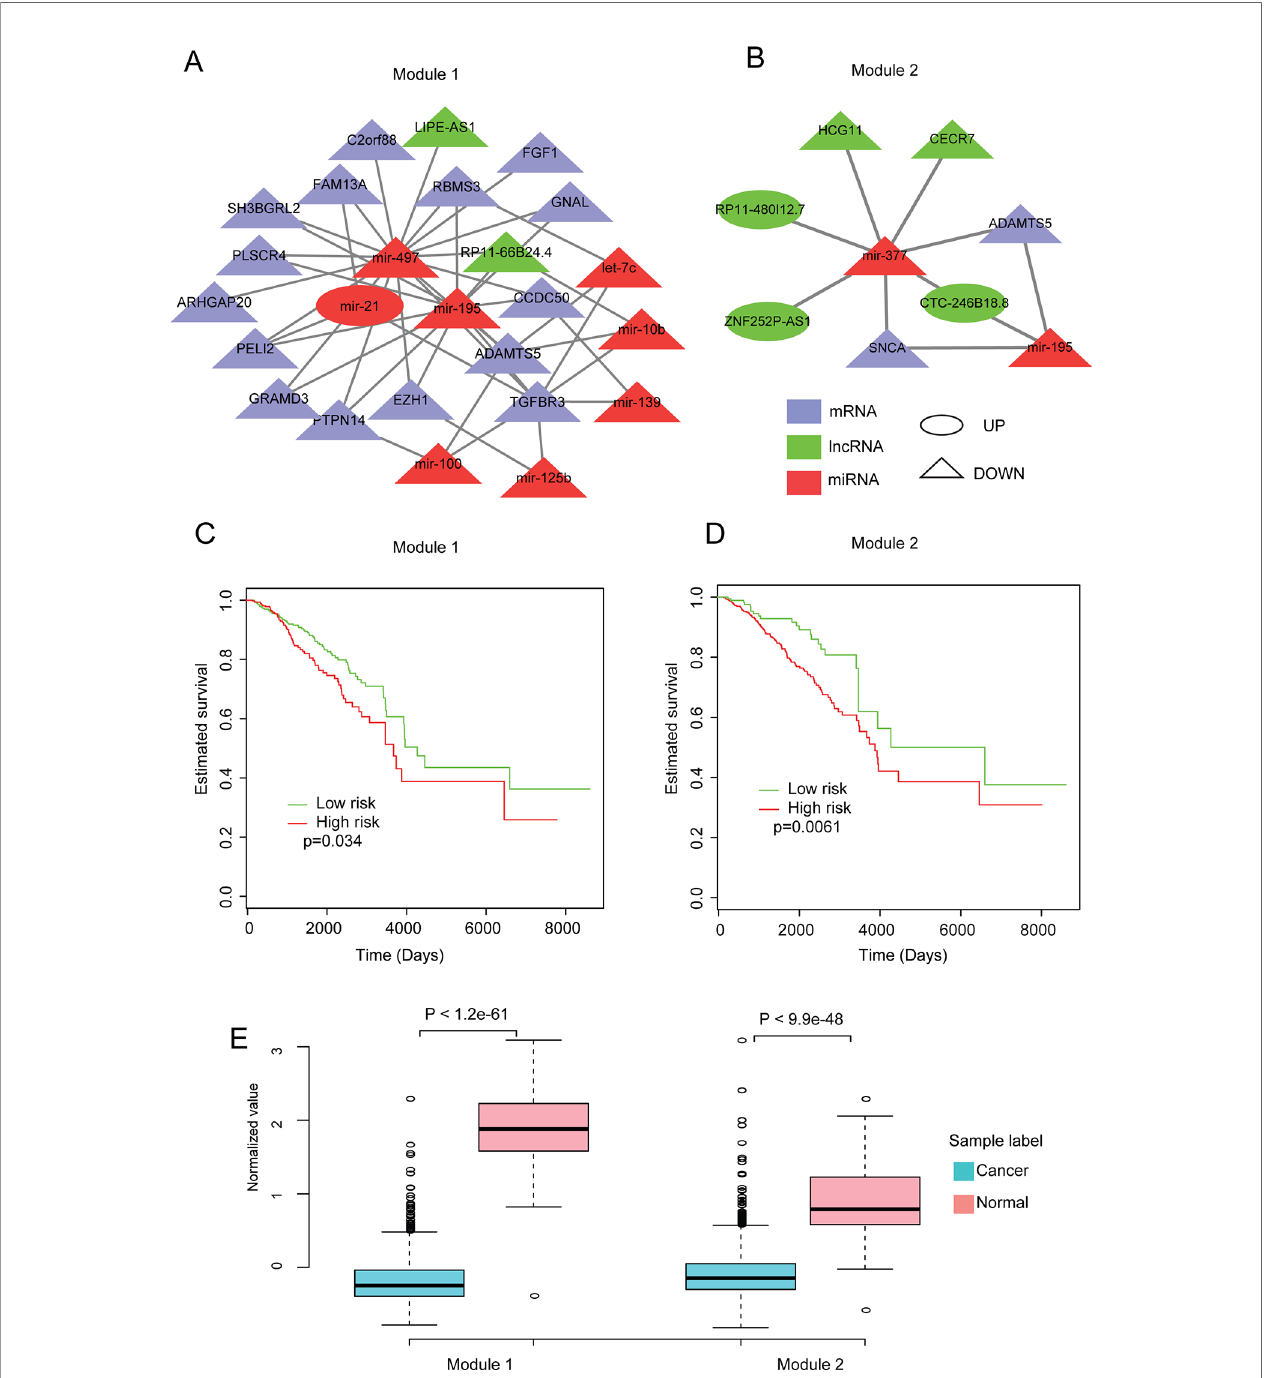
FIGURE 4 | Analysis of modules identi fi ed from the dysregulated network. (A , B) The two modules identi fi ed from the dysregulated network using Cytoscape with default parameters. (C , D) Kaplan-Meier plot of survival for these two modules. (E) Expression patterns of the modules in normal and cancer samples. The average expression value of each molecule crossing all normal/cancer samples was